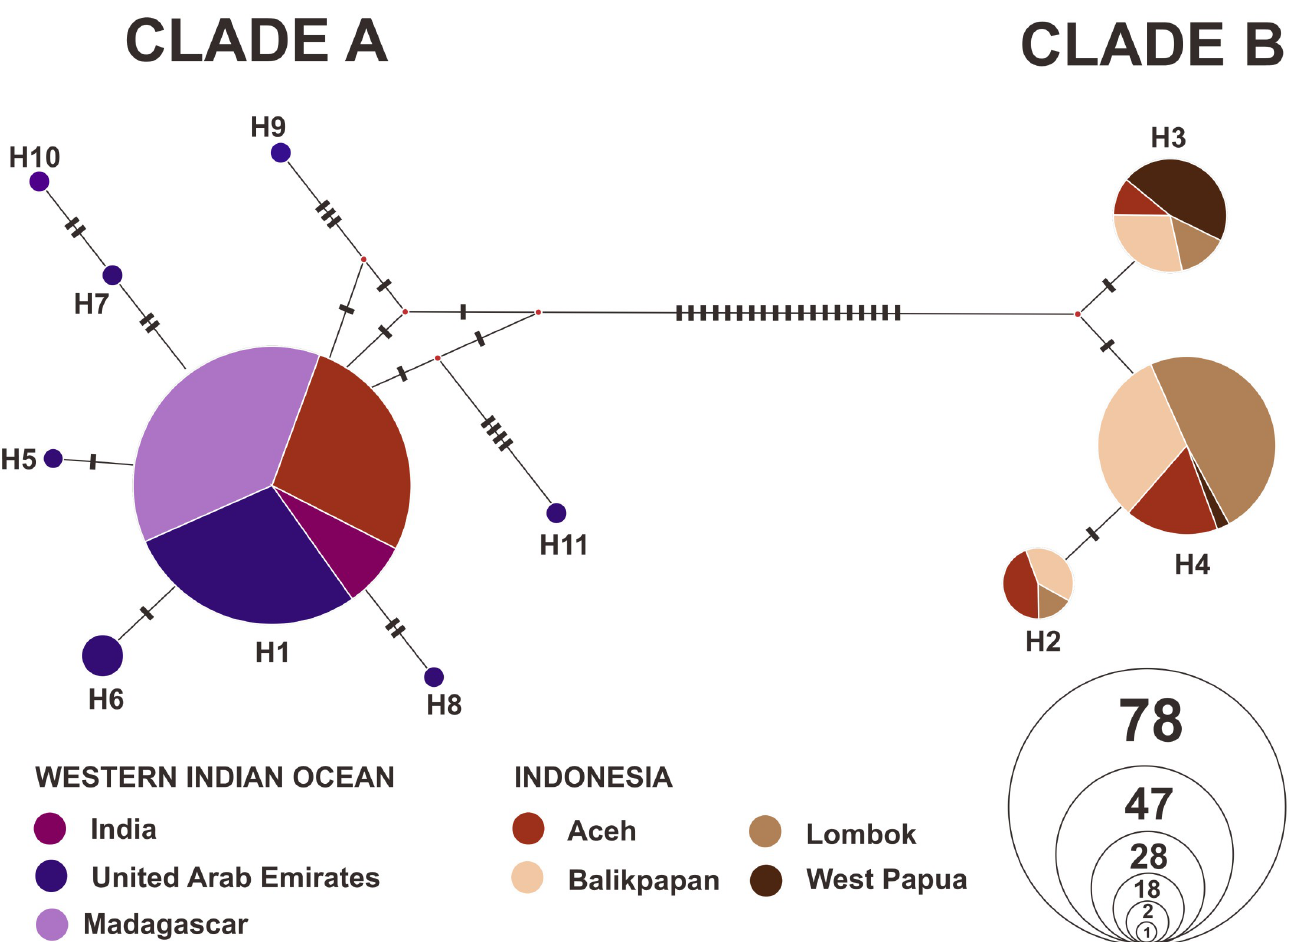
Fig 1. Haplotype network of the S . lewini (n = 179) population from Indonesia and the Western Indian Ocean region, which was constructed using the median joining method.